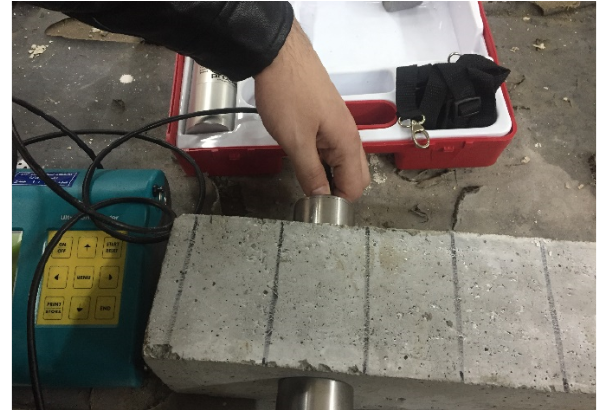
Figure 2: Ultra sonic testing of beam specimens as a fiber disper- sion